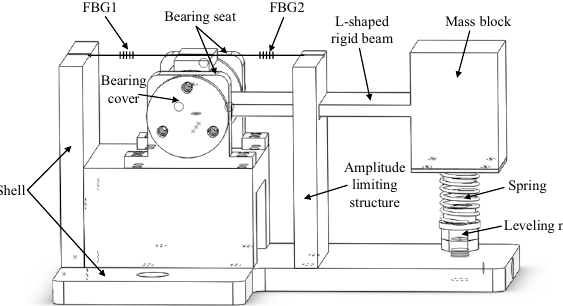
Figure 1. Structural modeling of the